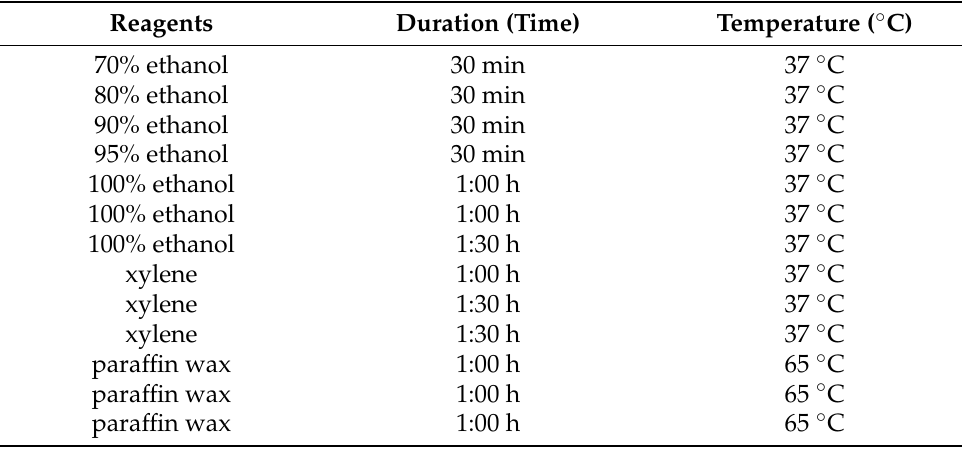
Table 6. The tissue processor: routine tissue processing